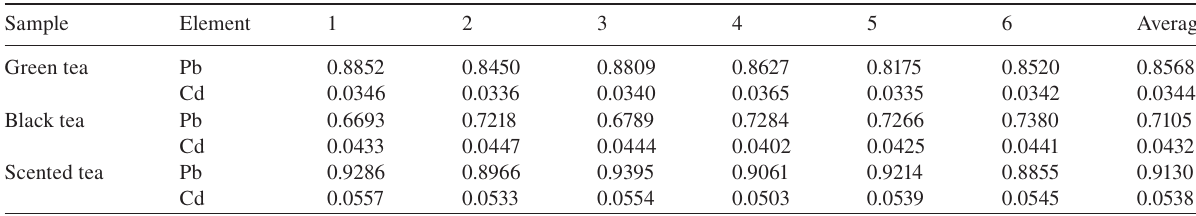
Table 3 Determination results for tea (mg/kg).